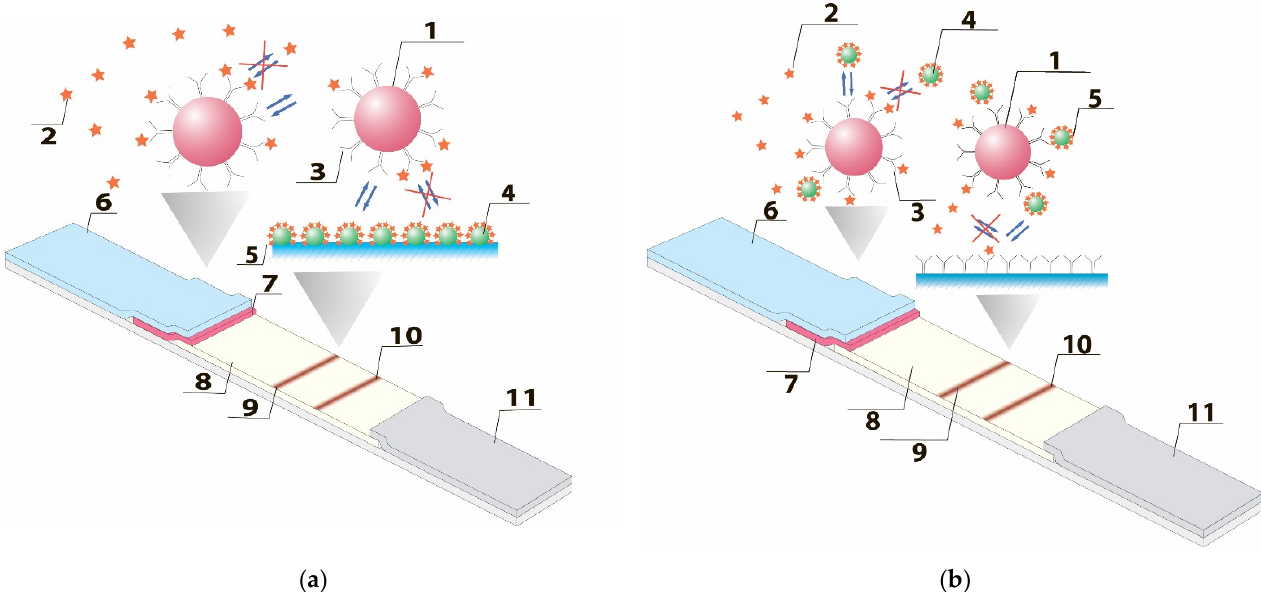
Figure 1. Scheme of the ( a ) standard and ( b ) proposed alternative competitive LFIAs. 1—Gold na- noparticles; 2—antigen in the sample; 3—antibodies against the antigen; 4—carrier protein; 5—an- tigen conjugated with carrier protein; 6—sample application membrane; 7—conjugate application membrane; 8—working nitrocellulose membrane; 9—analytical zone; 10—control zone; 11—final adsorbing membrane.